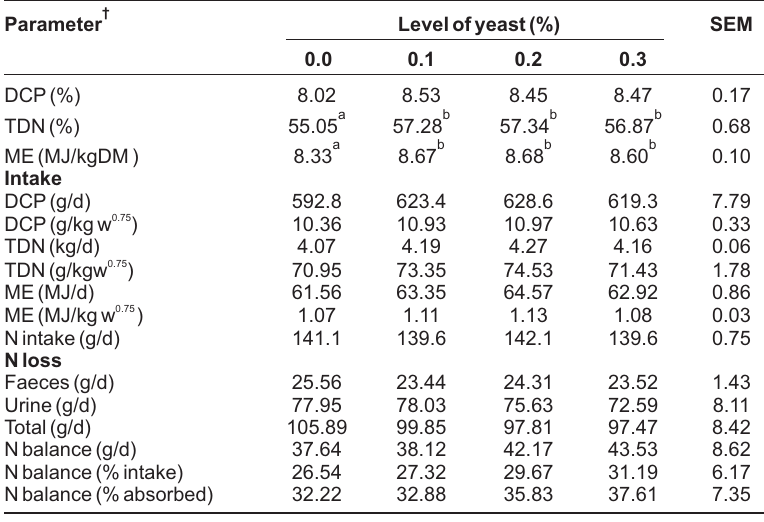
Table-3: Effect of different levels of thermo-tolerant yeast in complete ration on nutritive value, plane of nutrition and nitrogen (N) balance in Murrah buffalo steers